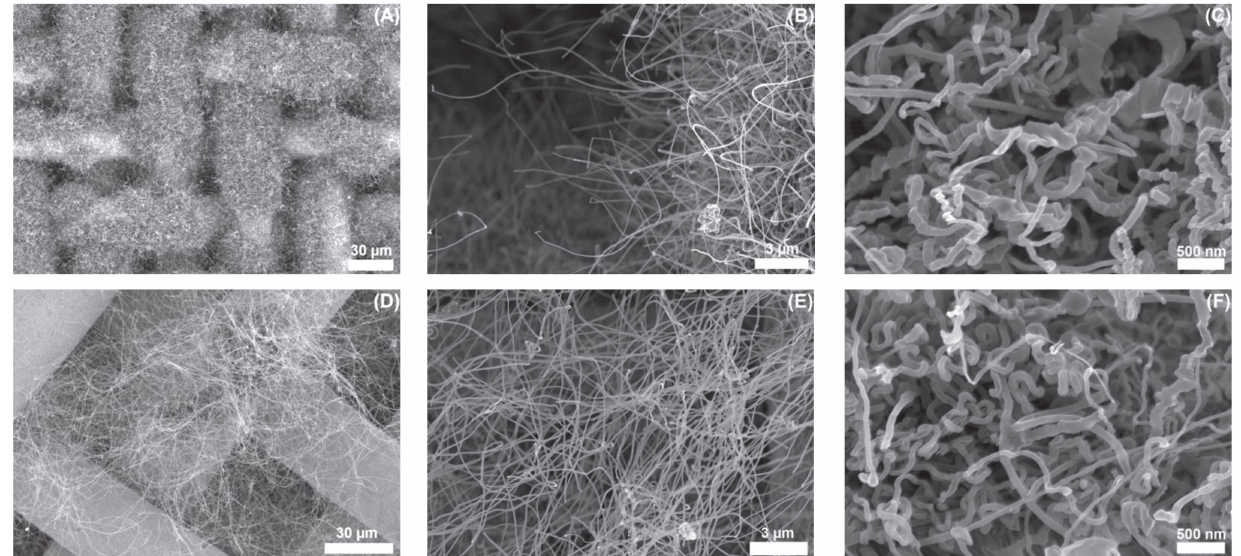
Figure 10. SEM images of sugarcane bagasse and pyrolysis temperatures of: 600 ◦ C ( A – C ); and 1000 ◦ C ( D – F ). Adapted with permission from Ref. [115].